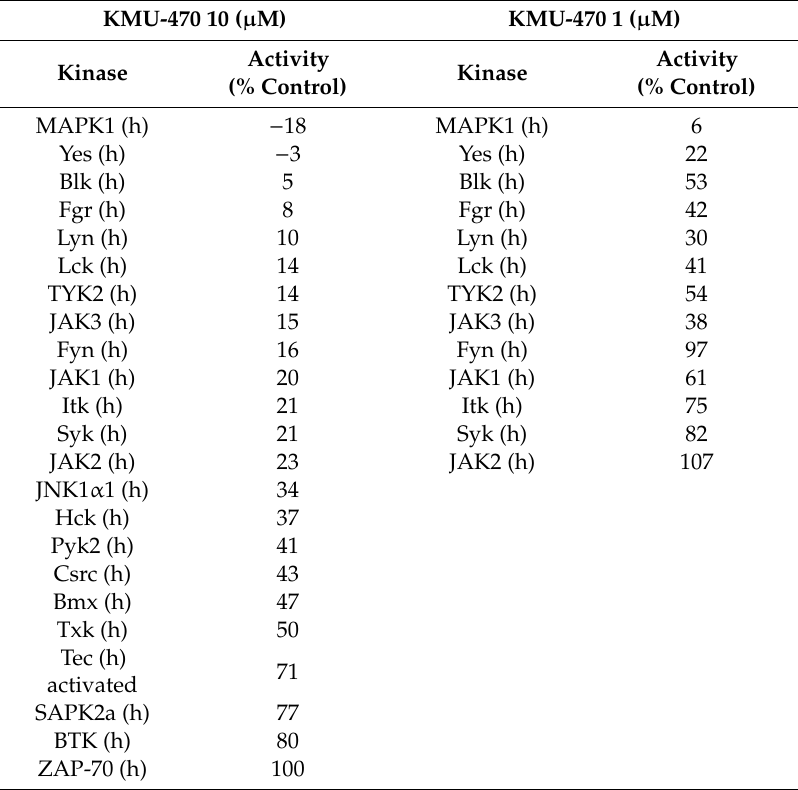
Table 2. Kinase inhibitory activities of KMU-470 against inflammation-related